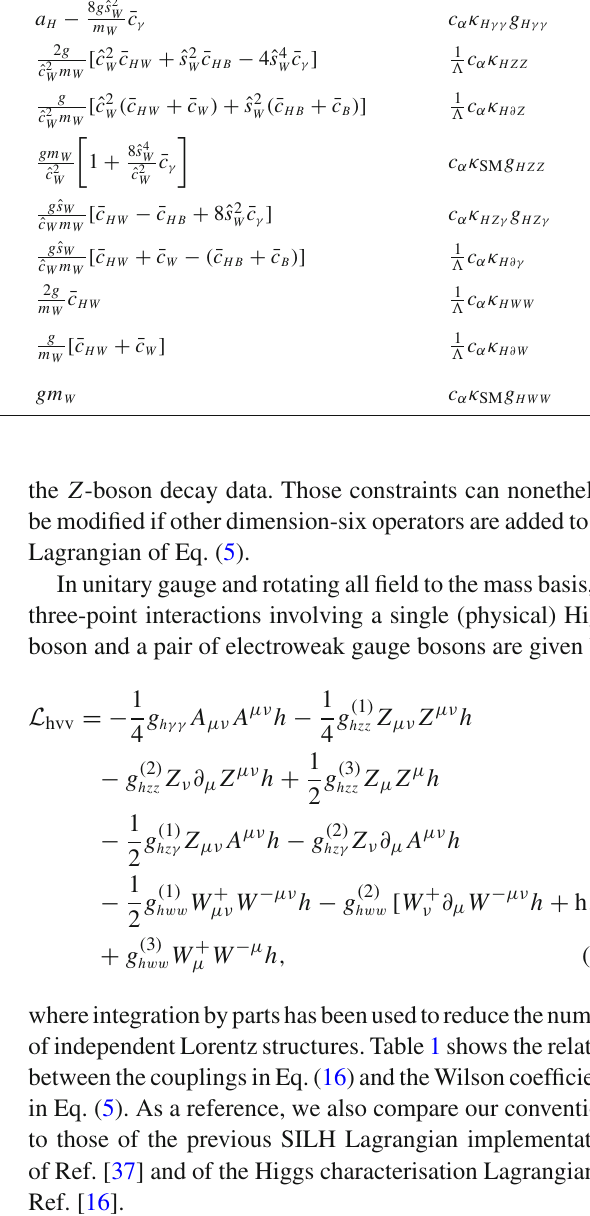
Table 1 New physics effects in three-point interactions involving a Higgs boson and electroweak gauge bosons. The loop-induced SM contributions to the Higgs-boson couplings to two photons a H and to one Z -boson and one photon a (cid:5) Equation (16) Our conventions Reference [37] (HEL) Reference [16]